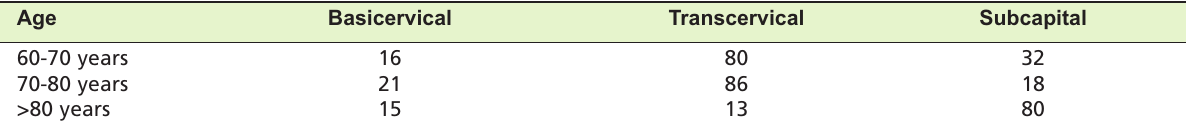
Age wise distribution of the fractures according to their anatomical location Table III: